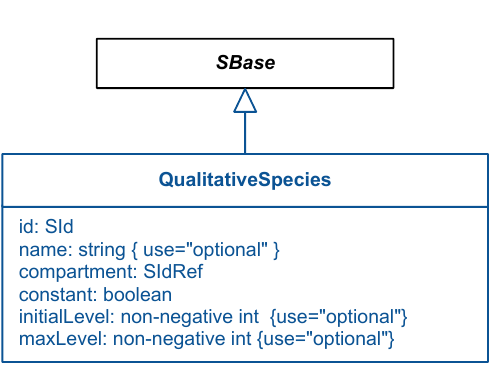
Figure 2: The definitions of the QualitativeSpecies